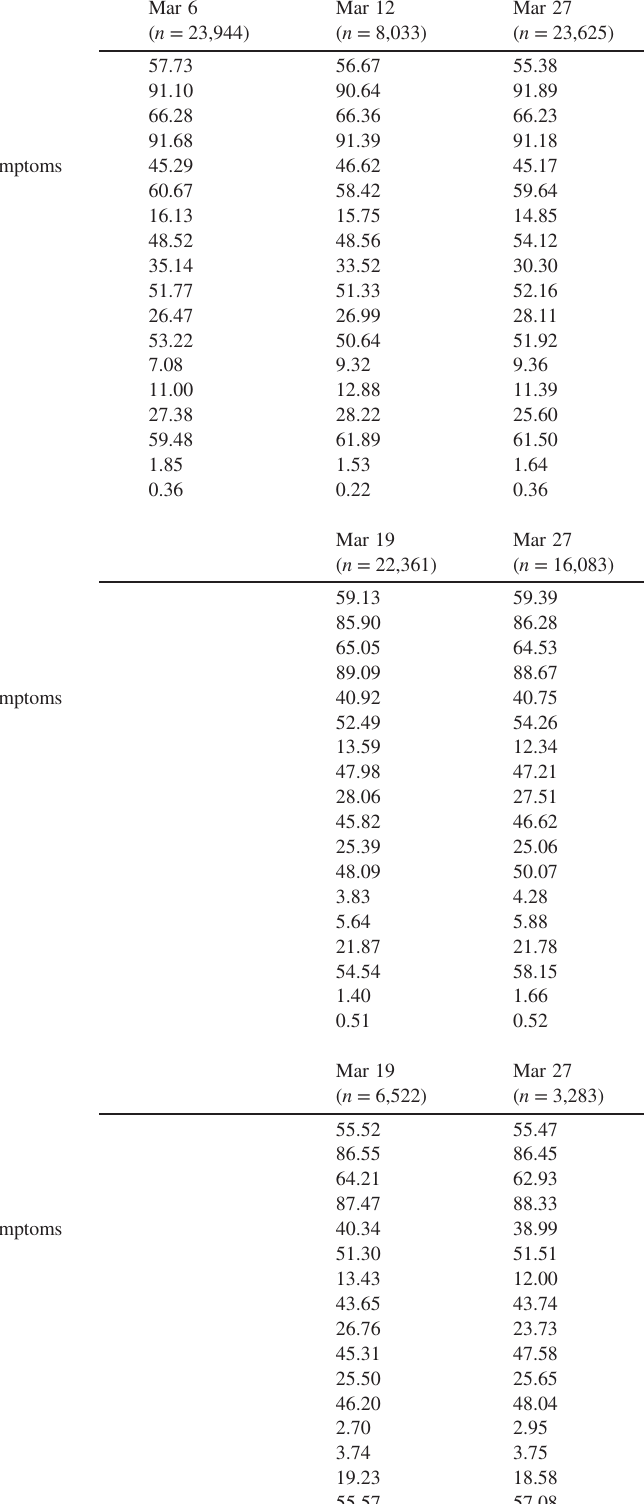
Table 2. Trends in proportions of preventive measures taken for Kanagawa, Aichi, and Shiga Prefectures Kanagawa Washing hands in running